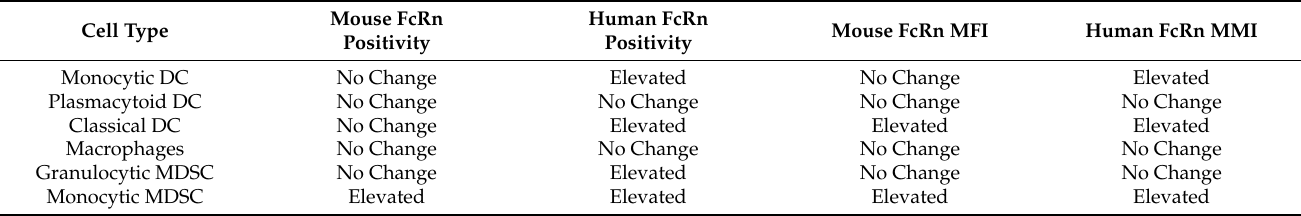
Table 2. Summary Table of FcRn Positivity and MFI/MMI. Summary table for the changes in monocytic DC, plasmacytoid DC, classical DC, macrophage, gMDSC and mMDSC FcRn positivity and MFI/MMI in both mouse and human samples relative to the tumor-free (TF) controls. Cell